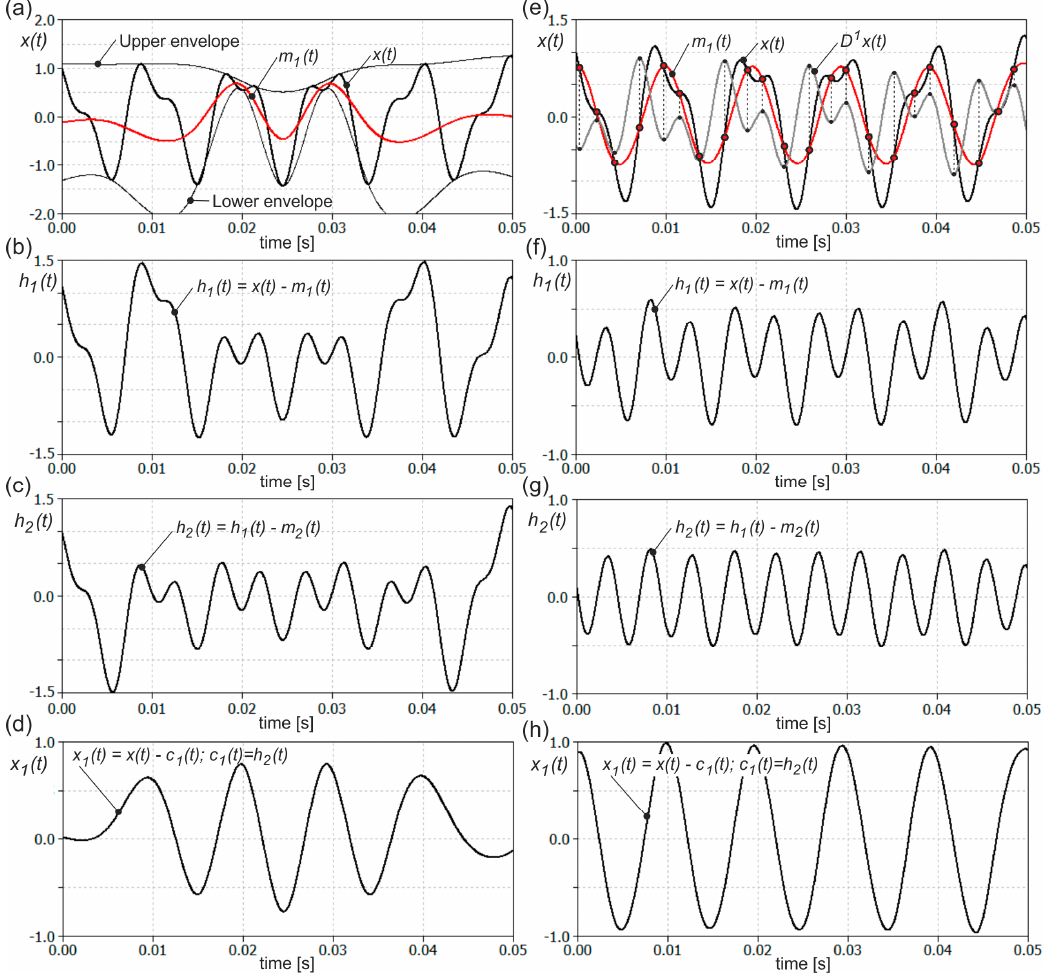
Figure 5. Empirical mode decomposition performed on two-tone signal x ( t ) = cos ( 2 π f 1 t ) − 0.43sin ( 2 π f 2 t ) where f 1 = 102 Hz and f 2 = 214 Hz: ( a – d ) with the use of standard mean line estimation based on upper and lower envelopes and ( e – h ) with the use of mean line estimation based on inflection points derived from the first derivate of the signal.